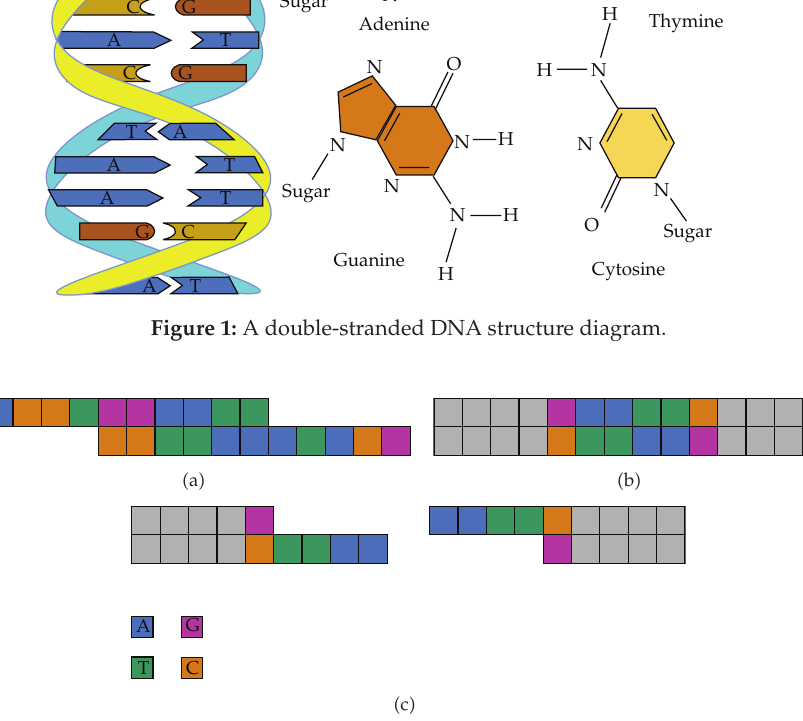
Figure 2: DNA molecules with sticky